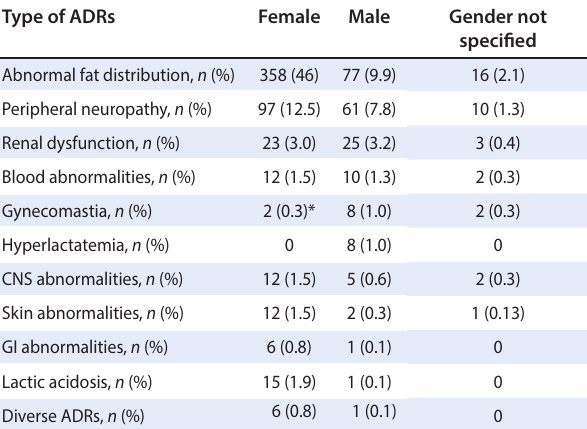
Notes: ADRs: adverse drug reactions; *breast hypertrophy; CNS: central nervous system; GI: